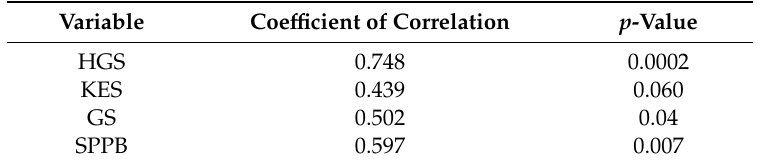
Table 4. Correlations between physical function variables and the MNA-SF